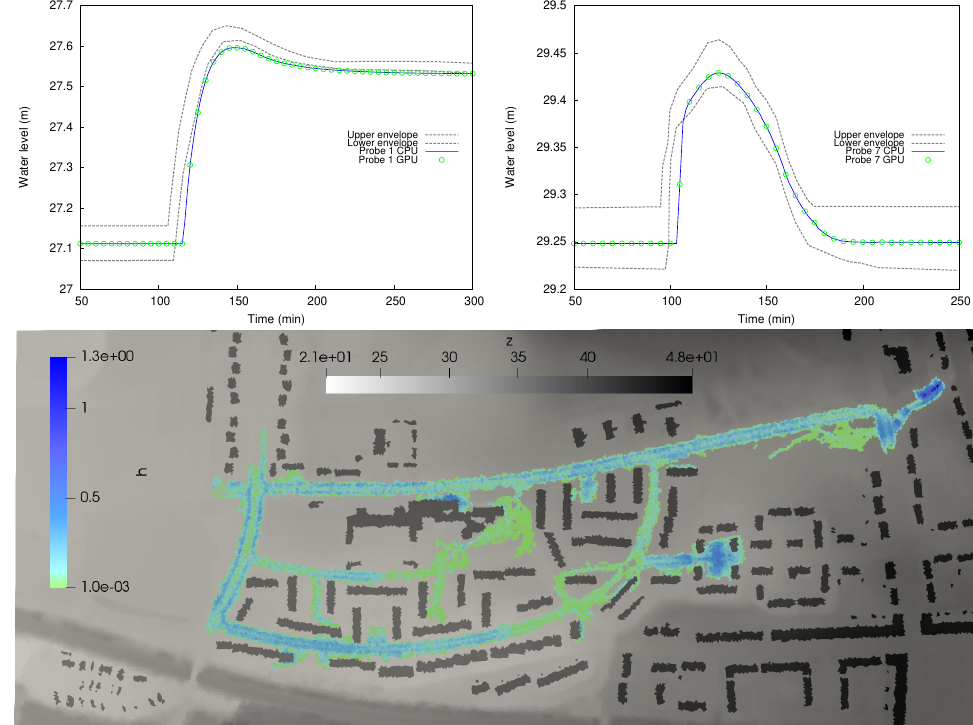
Figure 4. Case 1: Water level evolution at probes 1 ( upper , left ) and 7 ( upper , right ). Simulated flood extent at final